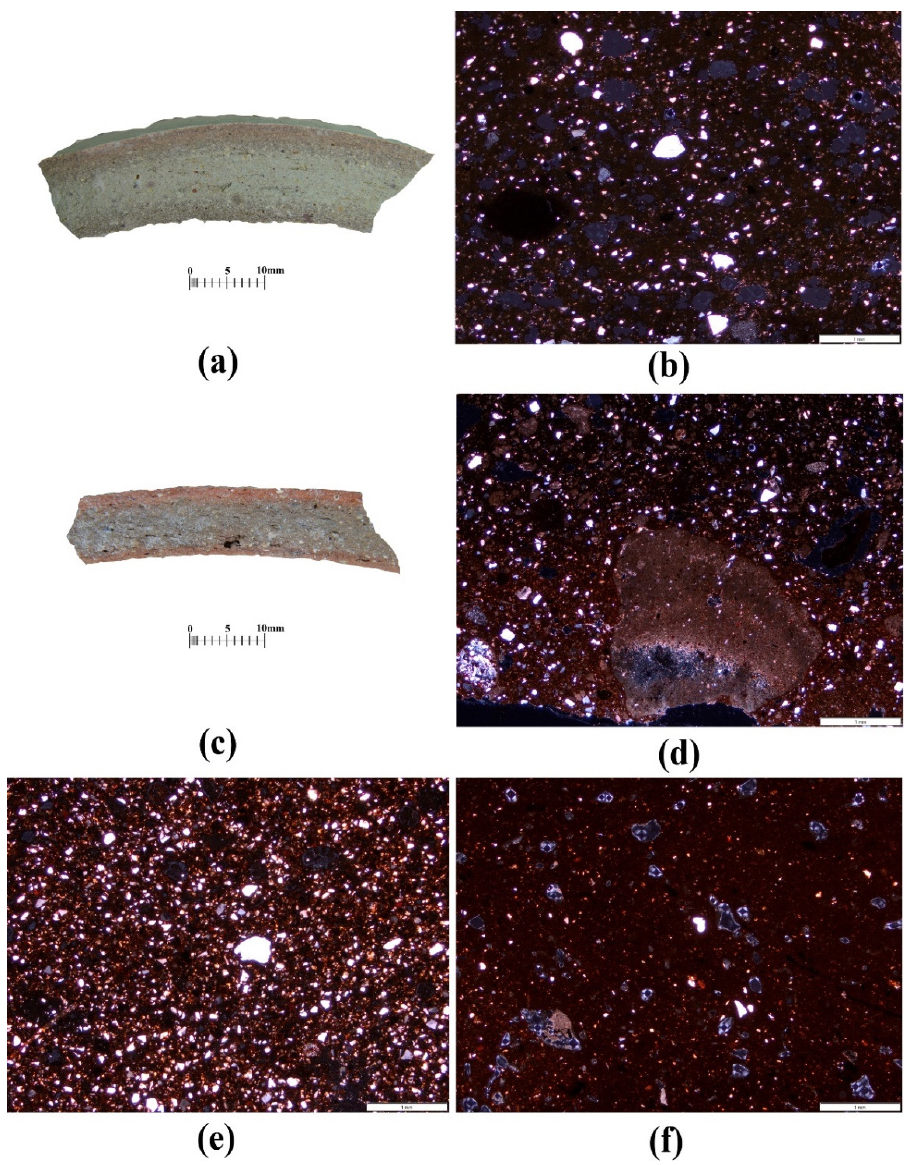
Figure 9. Fabric PPAL01a: macrophotograph ( a ) and photomicrograph in XP ( b ) of individual HIM174; fabric PPAL01b: macrophotograph ( c ) and photomicrograph in XP ( d ) of individual BAD007; photomicrograph of briquettes DPAM01 ( e ) and DPAM02 ( f ) fired at 850 °C.